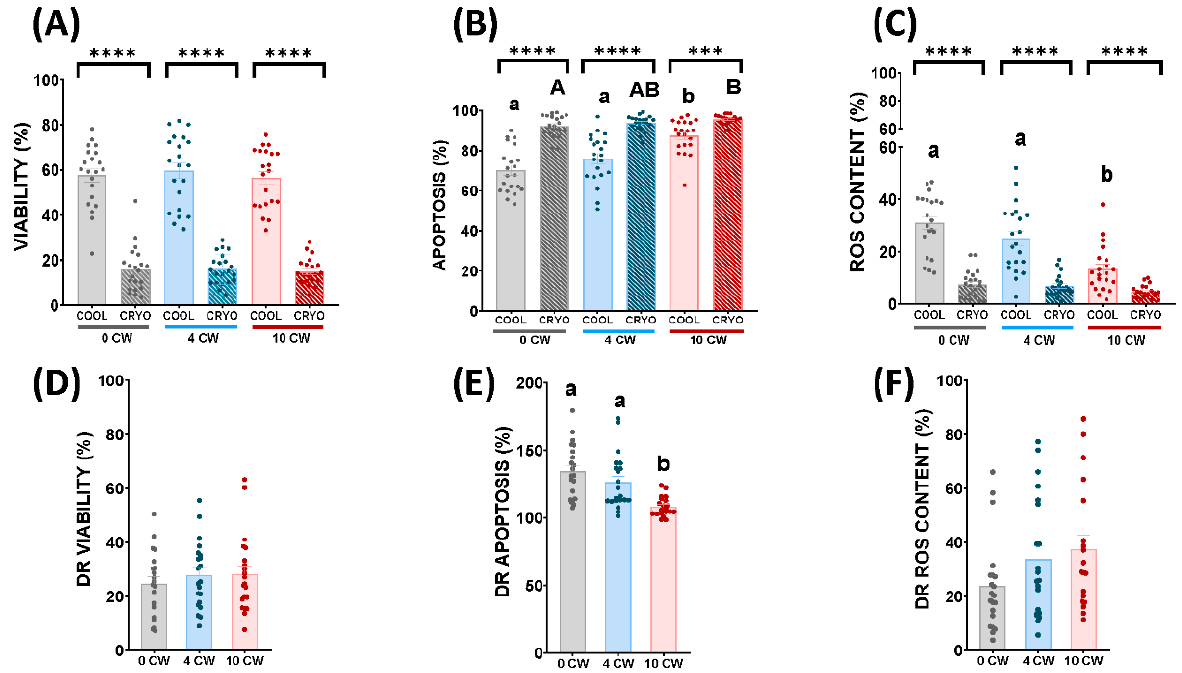
Figure 3. Ram sperm multiparametric analyses by flow cytometry in cooling (COOL) and frozen- thawed (CRYO) samples and differential rate (cooling/freezing) depending on the sperm collection frequency: without sperm collection (0CW), 4 sperm collections per week (4 CW), 10 sperm collections per week (10 CW). ( A ) Viability (%) (Zombie negative cells); ( B ) Apoptosis (%) (Caspase 3/7 positive cells); ( C ) ROS levels (%) (CellROX-positive cells); ( D ) Differential rate of viability (%); ( E ) Differential rate of apoptosis (%); ( F ) Differential rate of ROS content (%). Significant differences ( p < 0.05) among experimental groups in cooling samples are represented with different lowercase superscripts letters (a, b). Significant differences ( p < 0.05) among experimental groups in frozen-thawed samples are represented with different capitals superscripts letters (A, B). Significant differences ( p < 0.001, p < 0.0001) between cooling and frozen-thawed samples in the same experimental group are represented with asterisks (***, ****, respectively). Significant differences ( p < 0.05) among the differential rate of the experimental groups are represented with different lowercase superscripts letters (a, b). The same twenty-one males were analyzed in each experimental group.